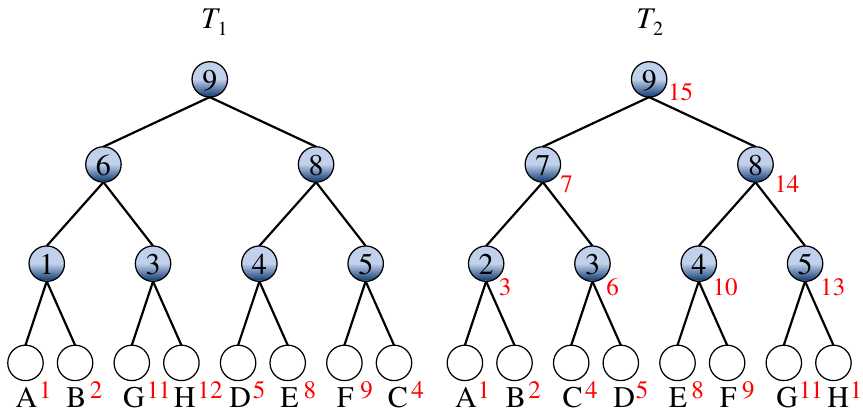
Figure 2. An example of ranking leaves of T 1 and T 2